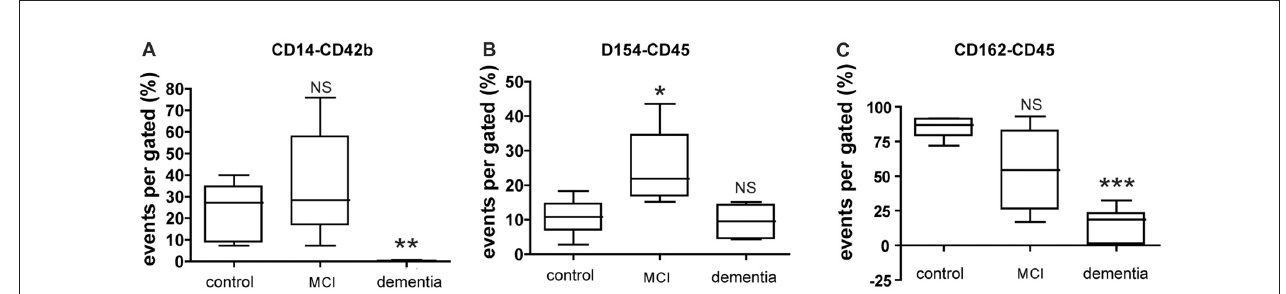
FIGURE 2 | Expression of circulating blood factors by fluorescence-activated cell sorting (FACS) analysis. (A) Circulating levels of monocyte aggregated with platelets in each group. (B) Circulating levels of leukocyte aggregated with CD40Ligand (CD154) in each group. (C) Circulating levels of leukocyte aggregated with p-selectin glycoprotein ligand (PSGL; CD162) in each group. The data presents with % as an event number per gate by FACS analysis. Bars represent median values, and the error bar, the standard deviation. ∗ p < 0.05 vs. control group, ∗∗ p < 0.01 vs. control group, ∗∗∗ p < 0.001 vs. control group. NS, not significant.